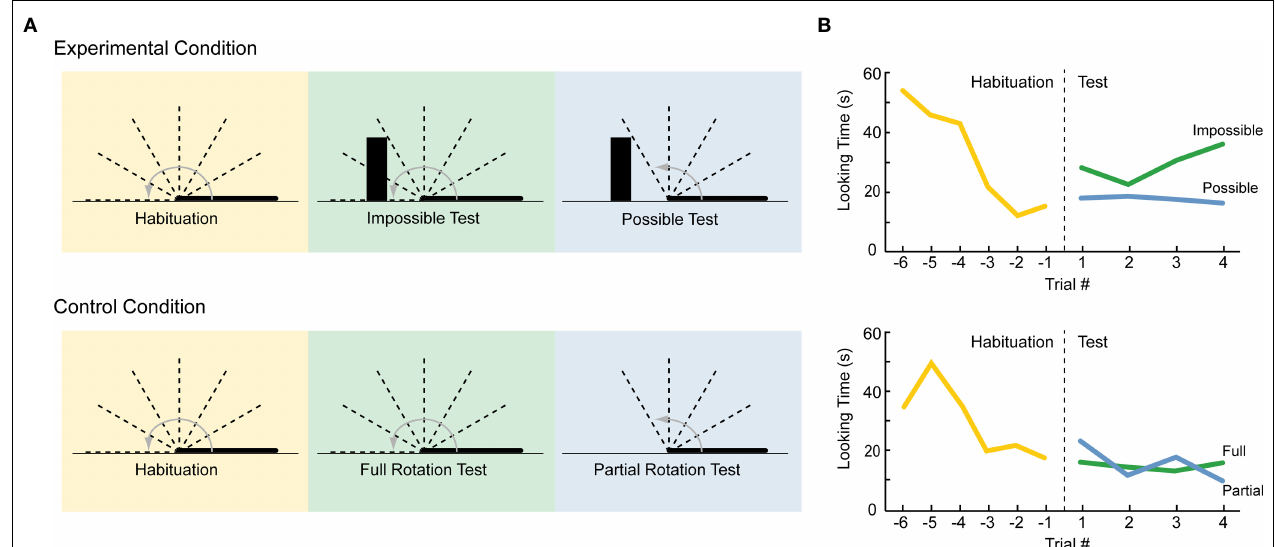
FIGURE 1 | An example of habituation in infant cognition (adapted from Baillargeon, 1987). (A) Side view of habituation and test displays. In both conditions, infants were habituated to a 180 ° drawbridge-like motion. The decline and plateau of looking times during habituation are depicted in the left panels of (B) . In the Experimental Condition, infants completed two types of test trials, both of which contained a new object on the far side of the display (depicted by the black box). The Impossible Test involved the same full 180 ° rotation from habituation, but now the screen surprisingly passed through the box as it completed its rotation (with the box disappearing as it became obscured). The Possible Test involved a novel shorter rotation of screen up to the point where it would contact the box, where it stopped; this motion was